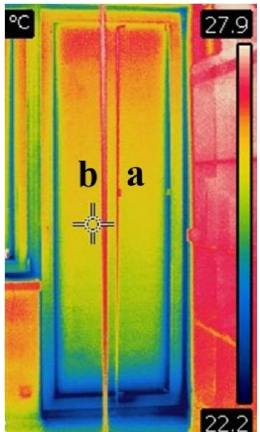
Figure A2. Illustrative infrared picture of a glazed balcony door. a : a thin textile ribbon installed 15 mm in front of the glazing surface; b : a thin textile ribbon at a distance of 1.4 m from the glazing. Both ribbons were used for indirect informative measurement of the temperature of the surrounding air.